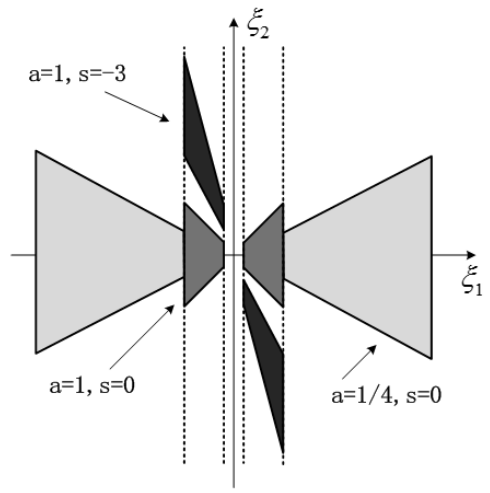
Figure 2. Frequency supports for different values of a and s ( a is the scale parameter, s is the shear parameter ).